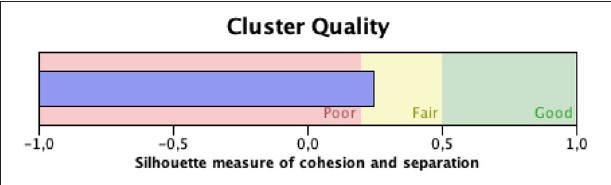
FIGURE 1 | Quality of the two-step cluster